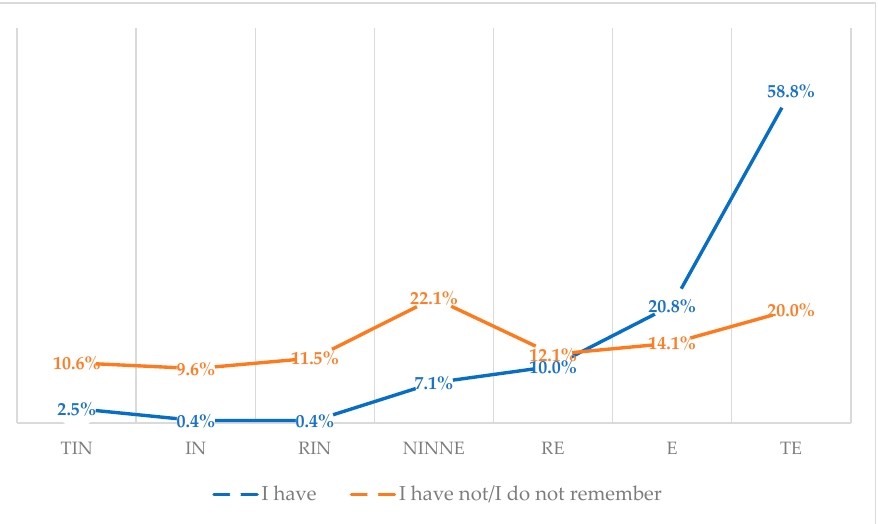
Figure 38. Attitudes toward influenza vaccination to prevent influenza virus infection among vaccinated and unvaccinated against influenza ( N = 950). Note. TIN-totally ineffective, IN-ineffective, RIN-rather ineffective, NINE-neither ineffective nor effective, RE-rather effective, E-effective, TE-totally effective.